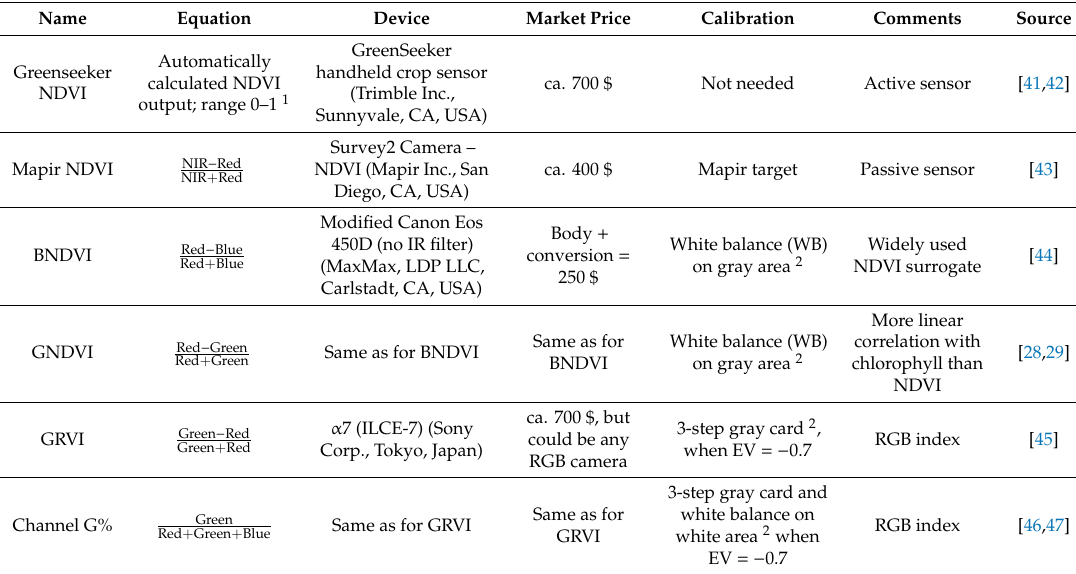
Table 1. Background information on the greenness indices used in this study. Market prices refer to price levels in